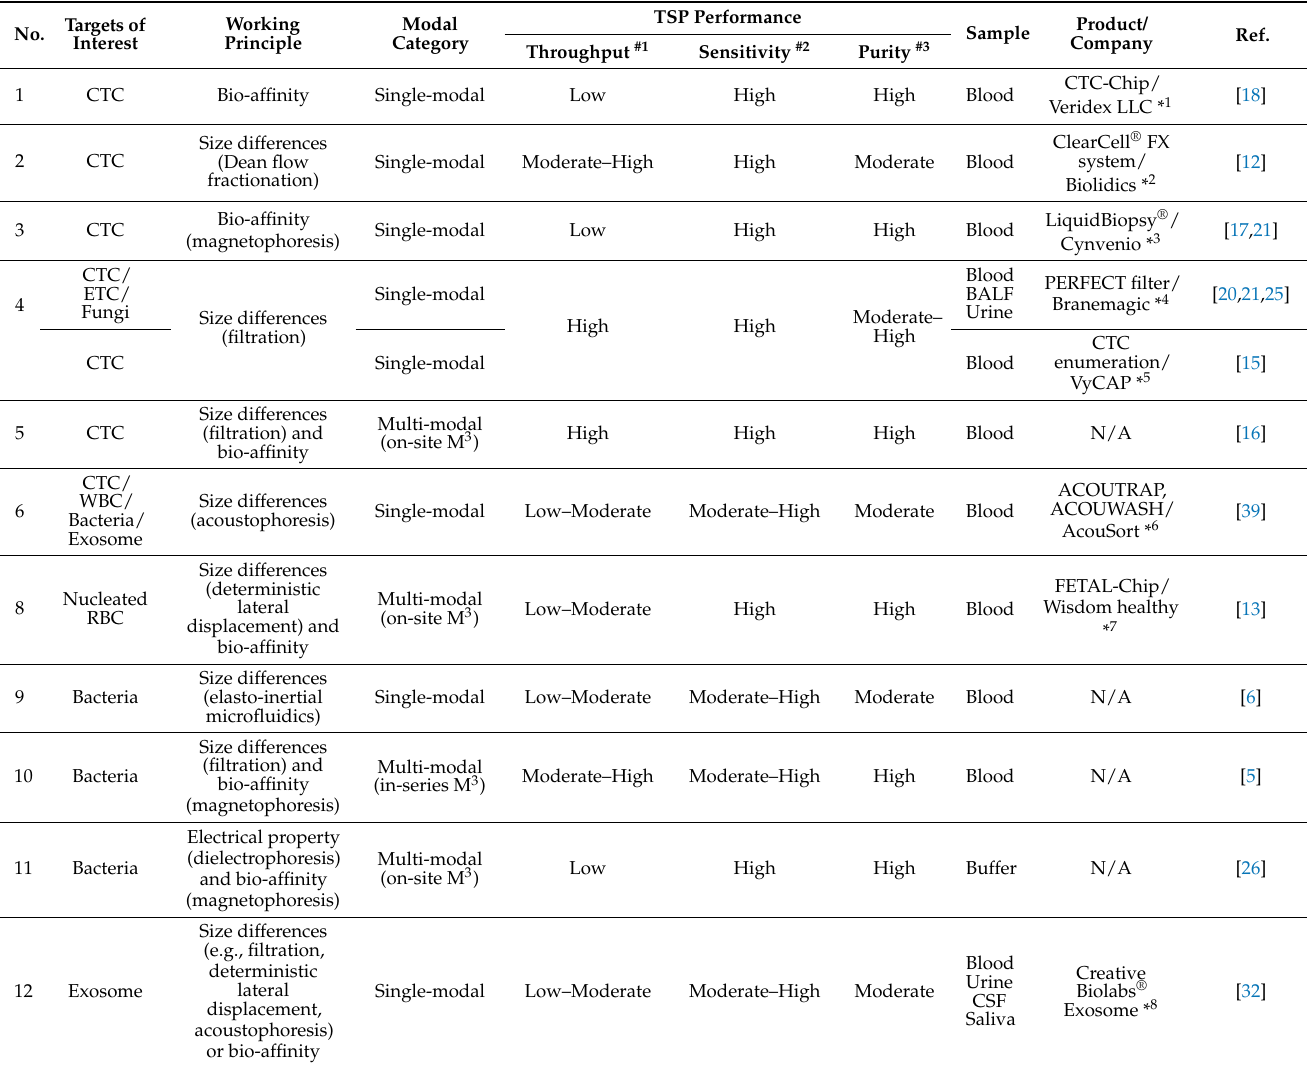
Table 1. List of typical microfluidic-based techniques for liquid